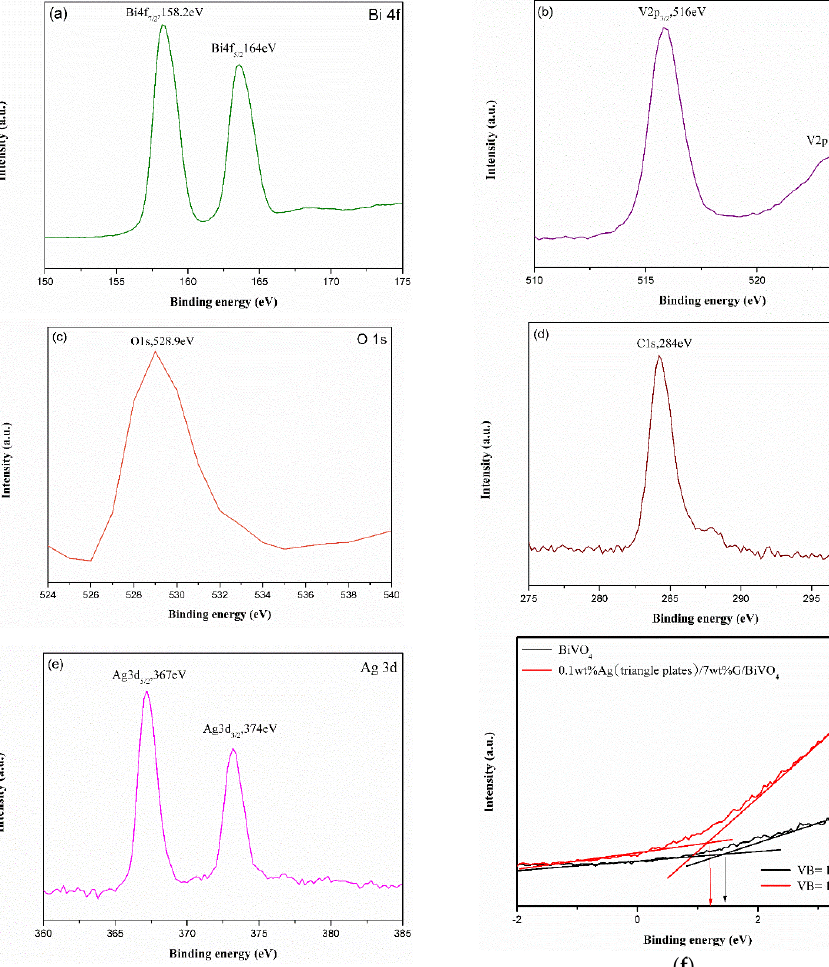
Figure 7. XPS spectra of 0.1%TAgNPt/7% graphene/BiVO 4 ; ( a ) Bi 4f spectrum, ( b ) V 2p spectrum, ( c ) O 1s spectrum, ( d ) C 1s spectrum, ( e ) Ag 3d spectrum, and ( f ) valence band spectra of BiVO 4 (black) and 0.1 wt% TAgNPt/BiVO 4 (red).